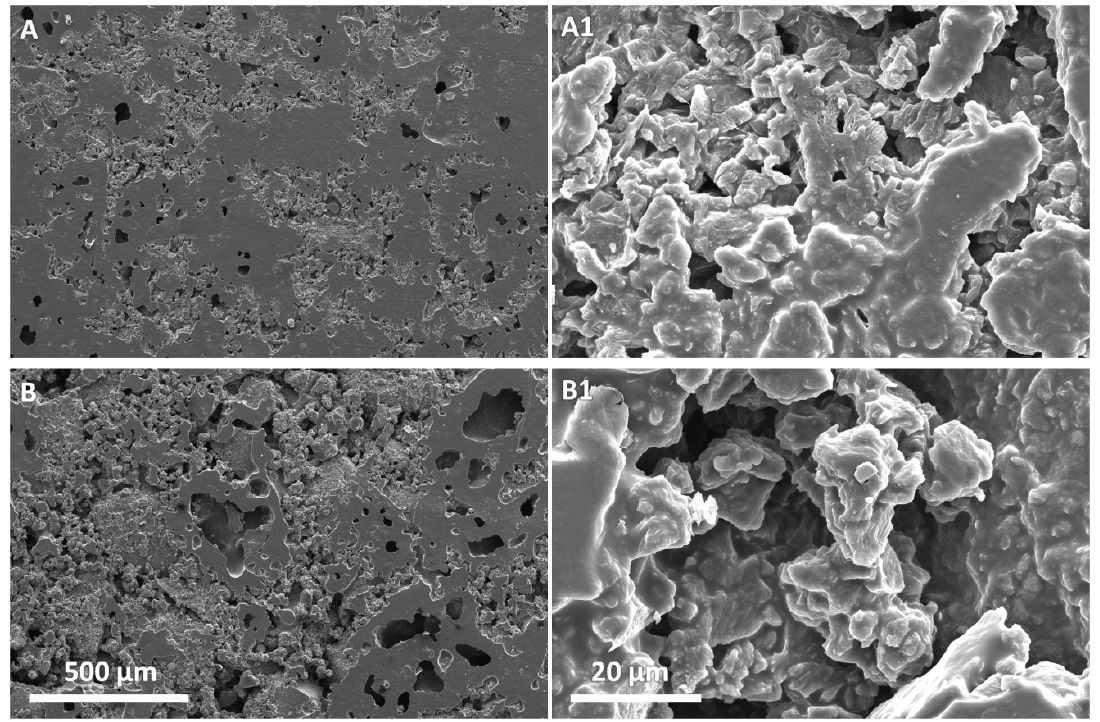
Figure 6. SEM micrographs at di ff erent magnification of the nanocomposite composed by PK30-Gly-Gly and hrGO at different weight percentage. ( A, A1 ) 5 wt. % and ( B, B1 ) 6 wt. %. Left pictures scale bar 500 μ m, right pictures scale bar 20 μ m.